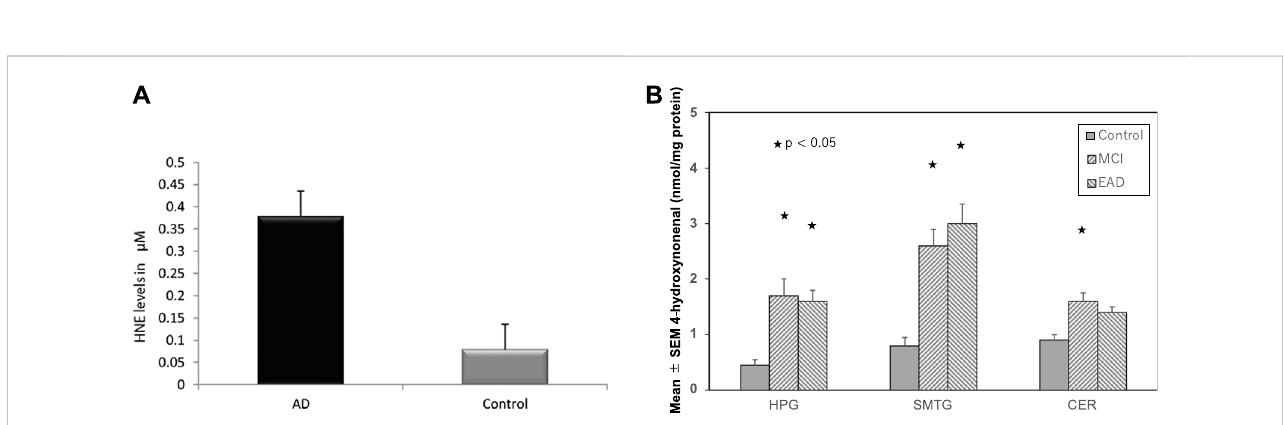
High hydroxynoneal levels in Alzheimer ’ s disease (AD) and mild cognitive impairment (MCI). Panel (A) The plasma hydroxynonenal level (HNE) in the patients with Alzheimer ’ s disease (AD) and the control subjects. (Cited from Rani et al., 2017). Panel (B) Tissue hydroxynonenal concentrations in the hippocampus/parahippocampal gyrus (HPG), superior and middle temporal gyrus (SMTG), and cerebellum (CER) in the patients of MCI, early Alzheimer ’ s disease (EAD), and age-matched control subjects. Adapted with permission from Williams et al.